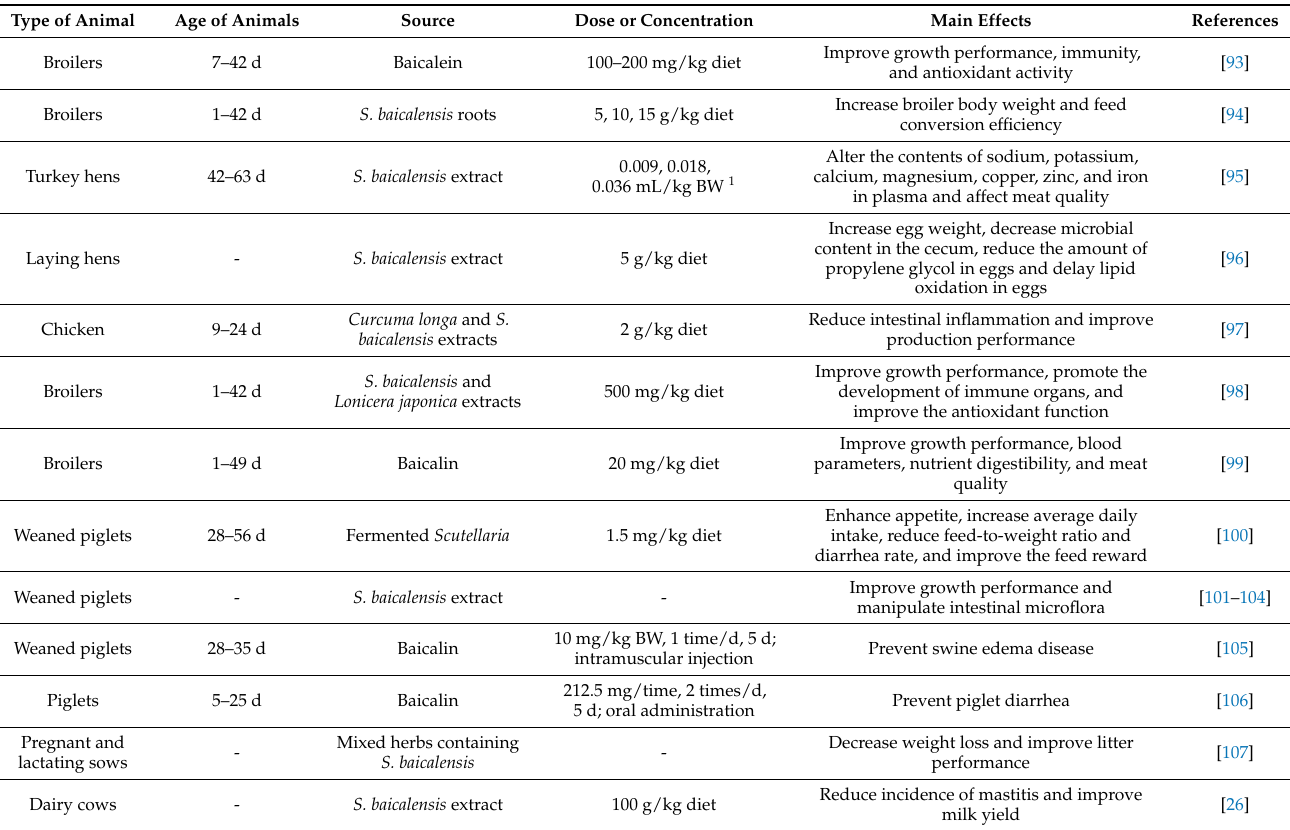
Table 2. The main effects of Scutellaria baicalensis on